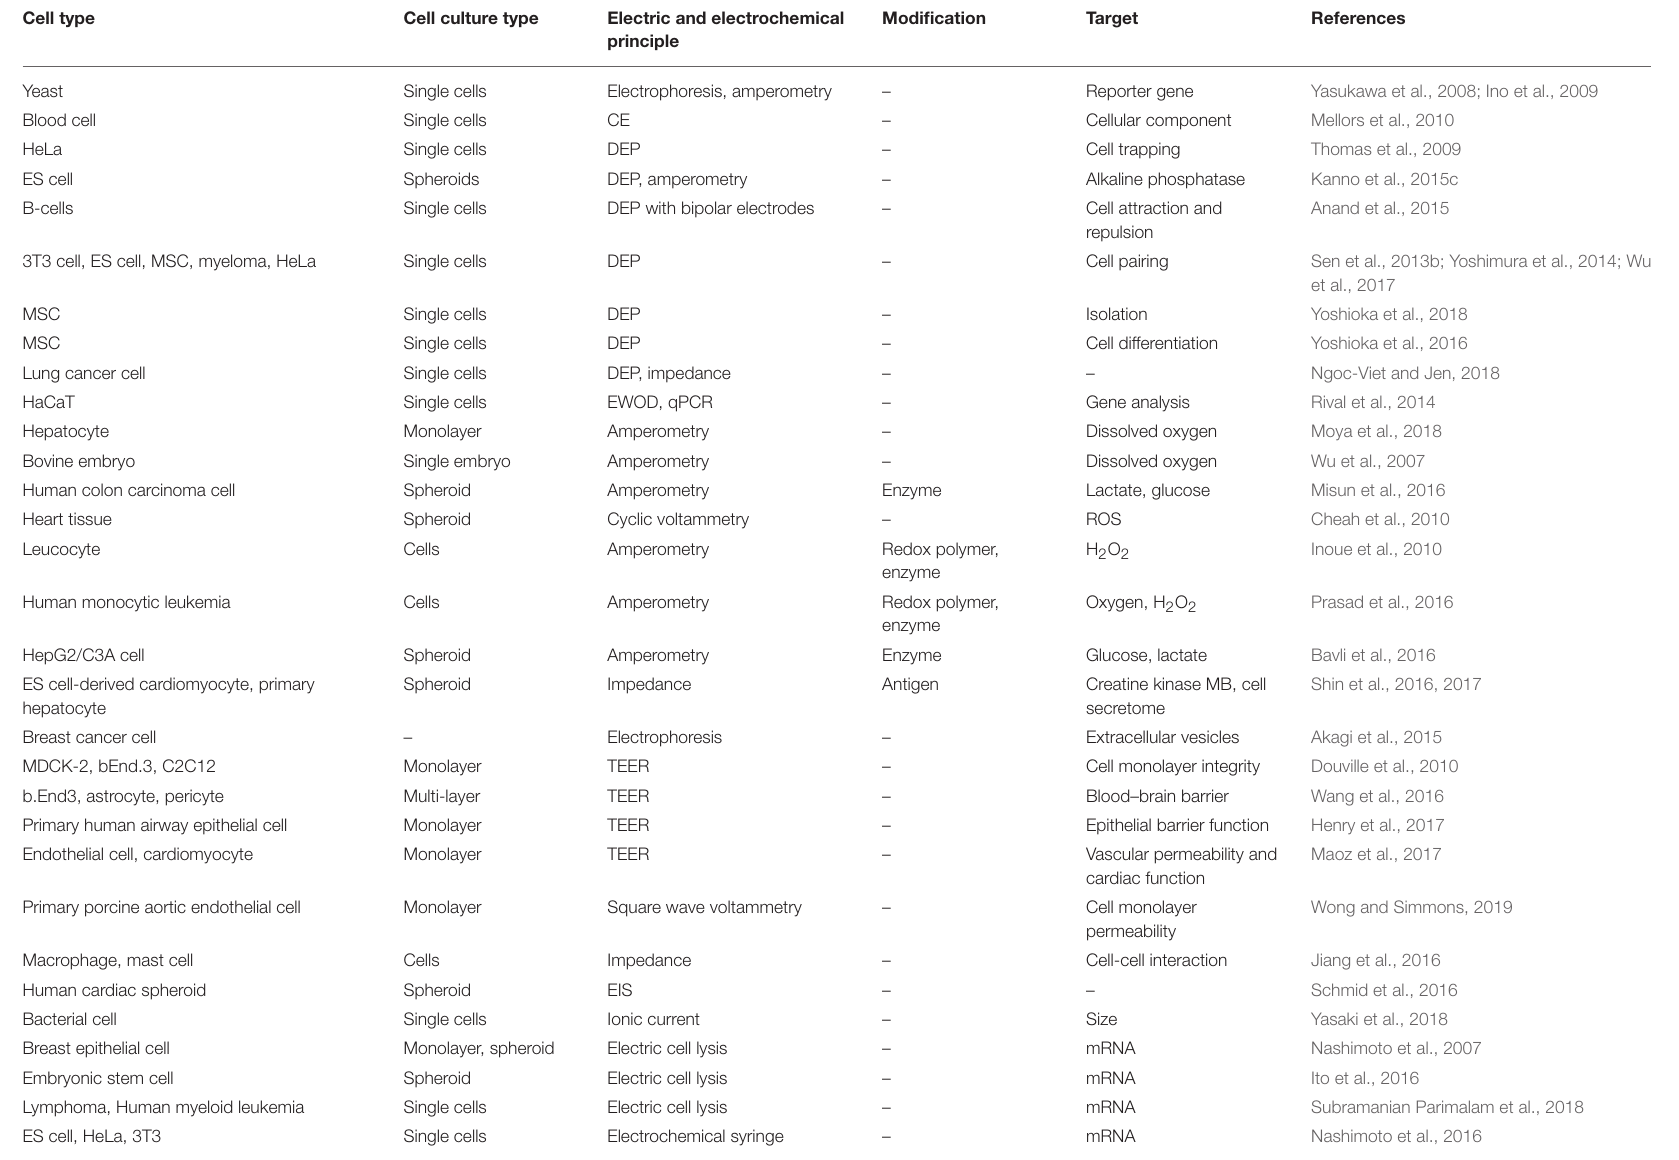
ES cell, Embryonic stem cell; 3T3 cell, fibroblast cell line; HeLa, cervical cancer cell; HaCaT, human keratinocyte; HepG2/C3A cell, Human hepatocellular carcinoma; MDCK, Madin-Darby canine kidney cell; b.End3, brain-derived endothelial cell; C2C12, mouse myoblast